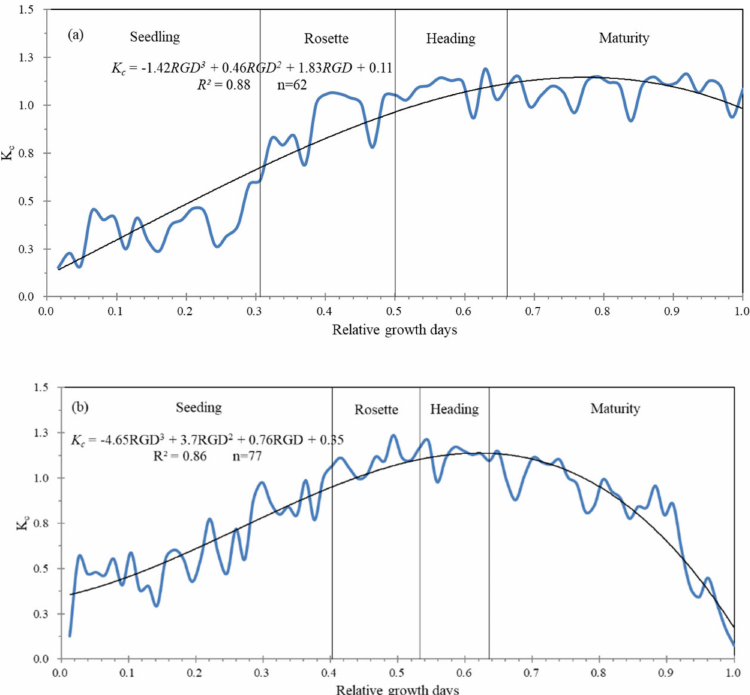
Figure 6. ( a ) Seasonal K c variations of Chinese cabbage throughout the growing period of the first crop; ( b ) seasonal K c variations of Chinese cabbage throughout the growing period of the second